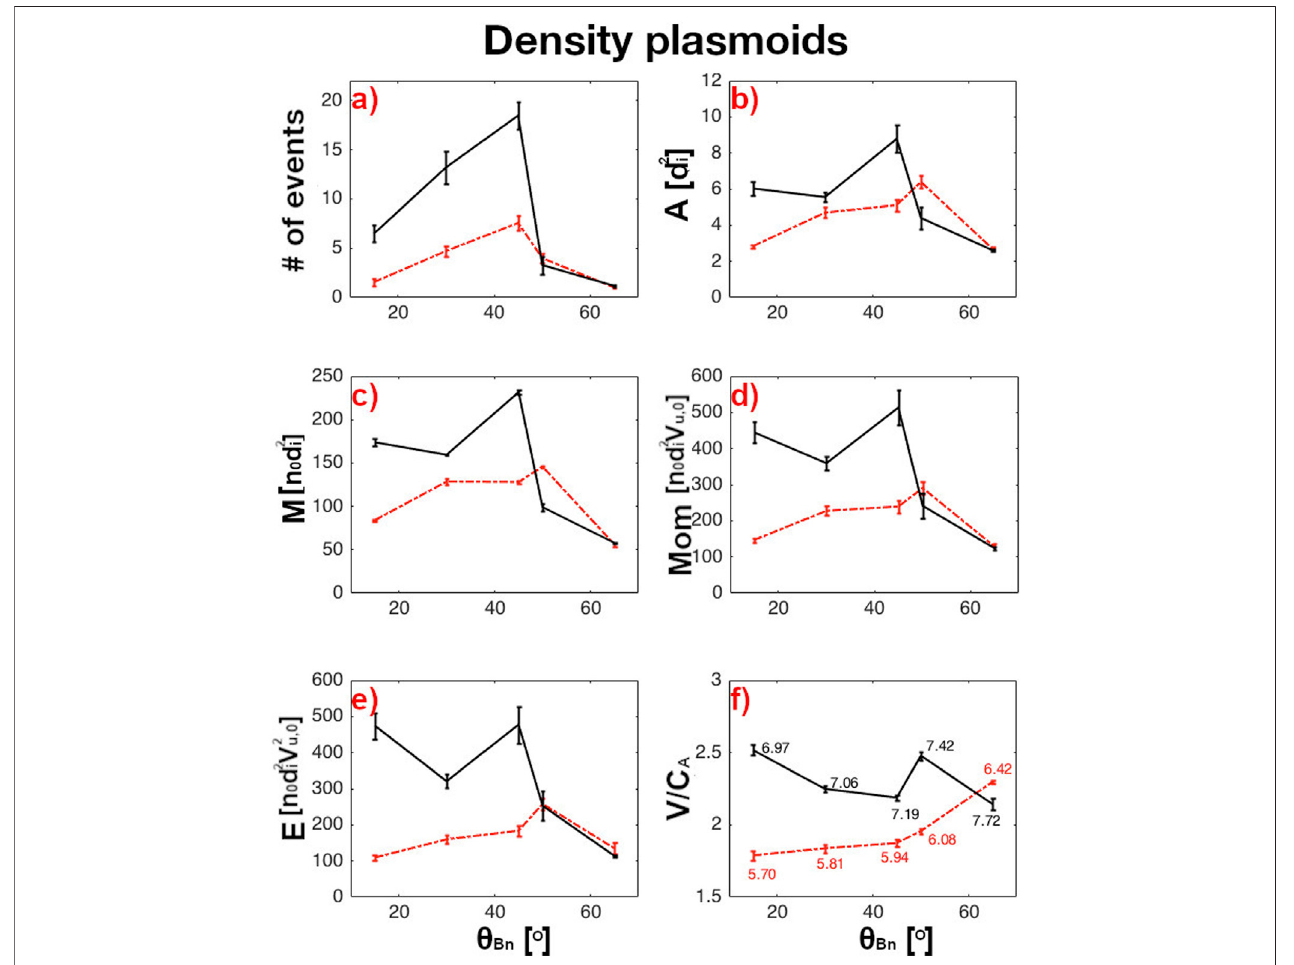
FIGURE 5 | Average properties of density plasmoids as a function of θ BN . Figure format is the same as in Figure 3 . The red and the black traces represent propertiesofjetsproducedinrunswith4.5C A and5.5C A respectively.Theunitsaregiveninbrackets.Thesubindex u referstotheupstreamregion,whilethesubindex0 means the initial